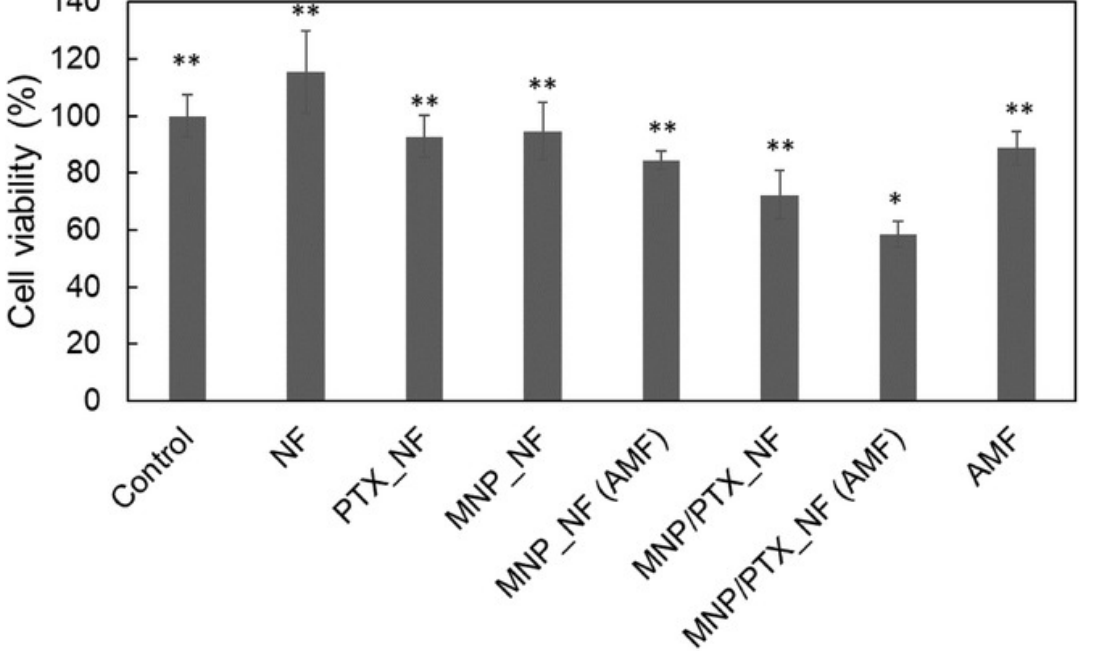
Figure 10. Cytotoxicity test using NF (nanofibre mesh without MNPs and PTX), MNP_NF (nanofibre mesh with only MNPs), MNP_NF (AMF) (nanofibres mesh with only MNPs upon AMF), PTX_NF (nanofibres mesh with 0.3 mg of PTX), MNP/PTX_NF (AMF) (nanofibres mesh with MNPs and 0.3 mg of PTX upon AMF) and AMF (*, ** p < 0.05). Reprinted/adapted with permission from Ref. [72]. 2022, John Wiley and Sons.